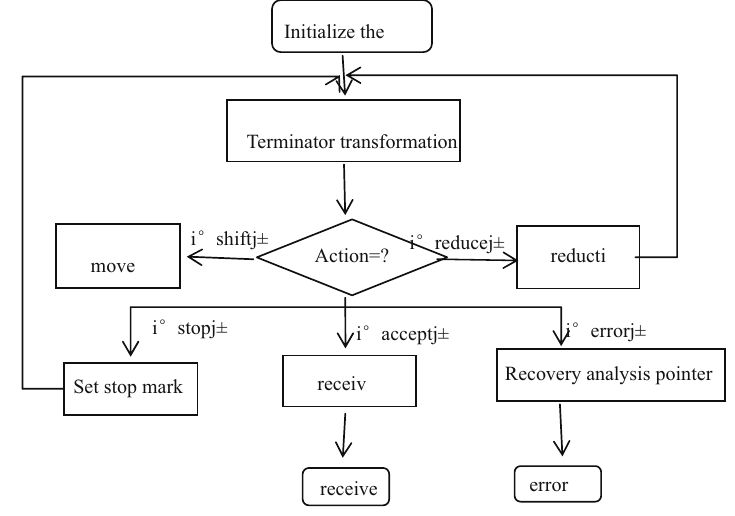
Figure 3: Syntactic analysis algorithm based on GLR.